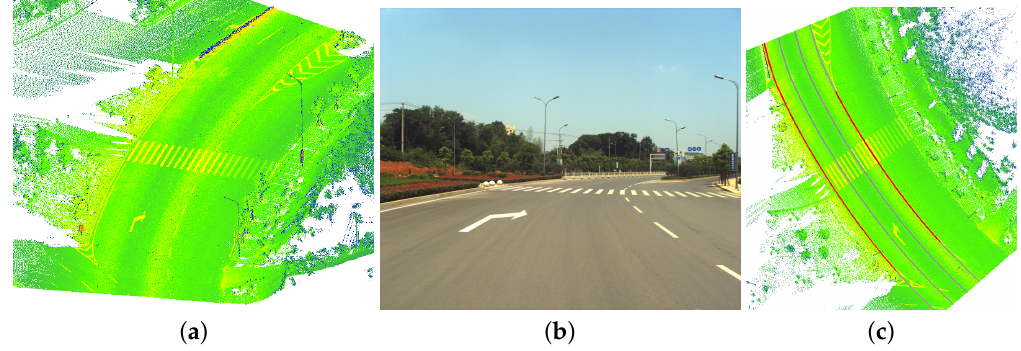
Figure 25. Error analysis: the irregular lane. ( a ) The raw data with a 10.5 m wide lane. ( b ) The corresponding MMS image. ( c ) Four lines are obtained by global post-processing. Correct extractions are red, and the false positives are